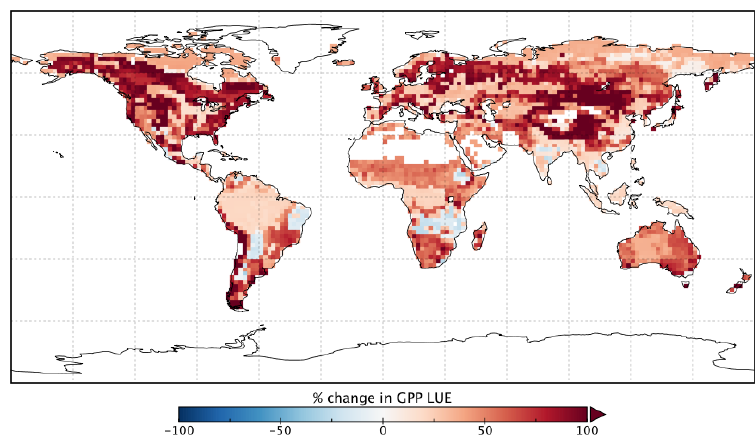
Figure B4. Percentage change in annual mean LUE GPP following the SIF assimilation.